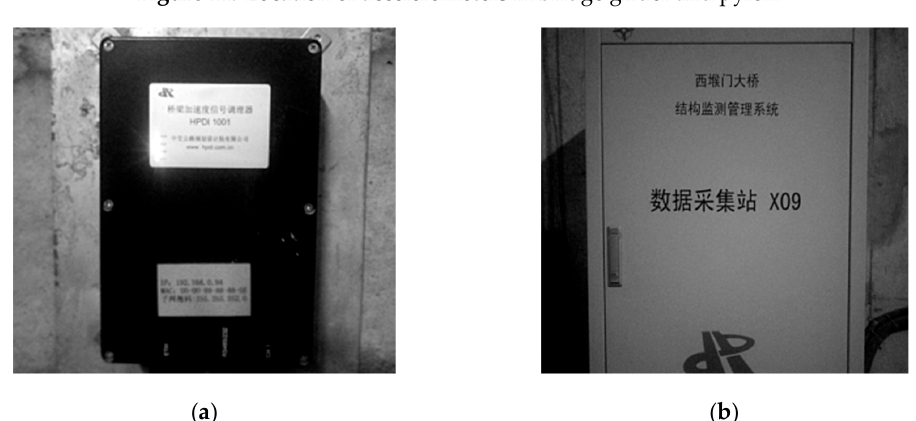
Figure 15. Date logging system: ( a )Acceleration signal conditioner; ( b )data acquisition sub-station.